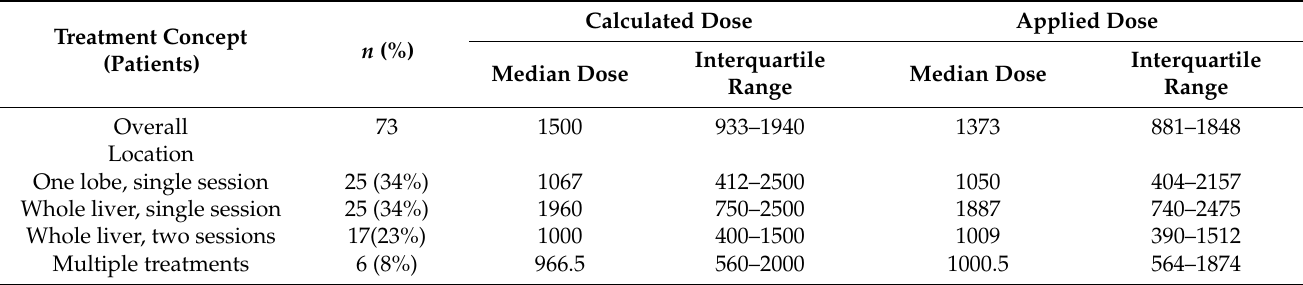
Table 2. Location of radioembolization and dosimetry